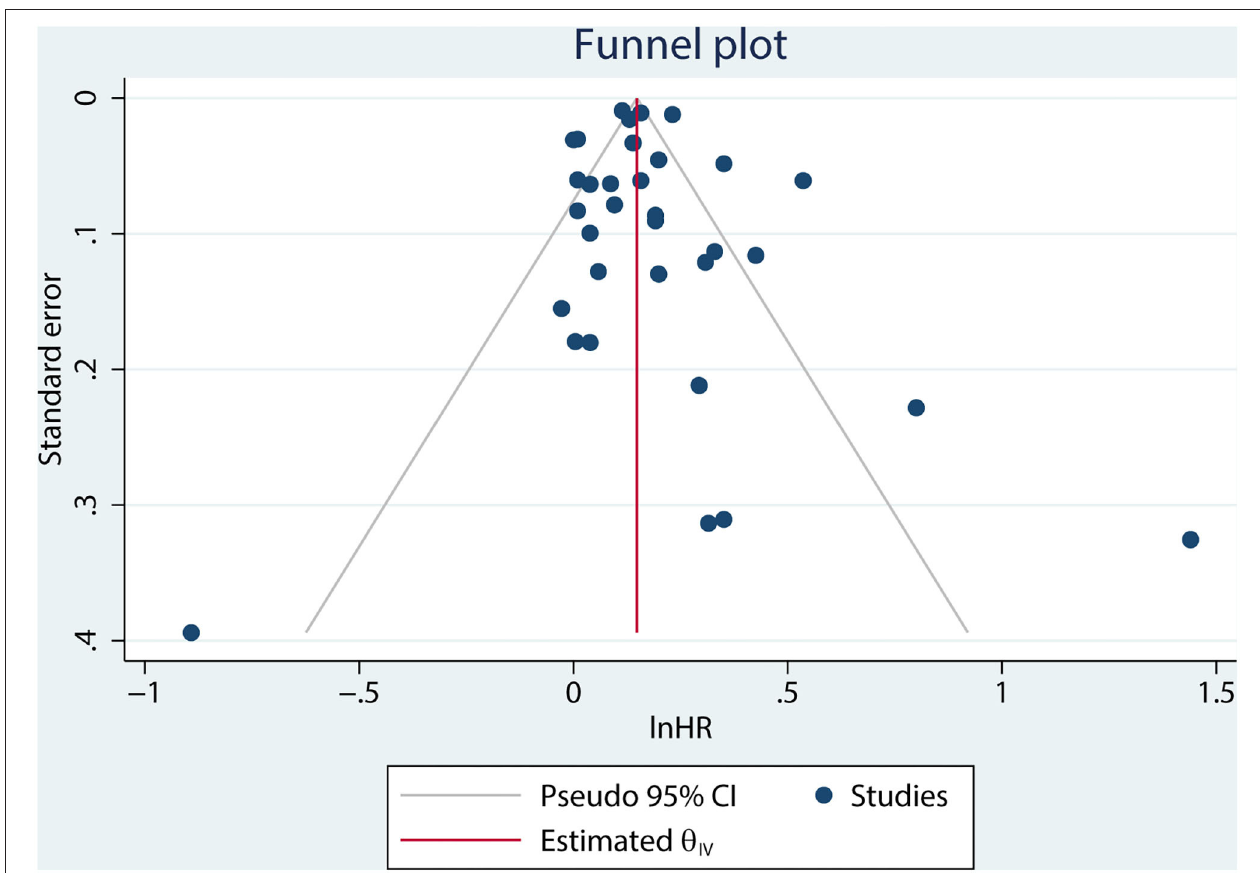
FIGURE 3 | Funnel plot of publications included in the